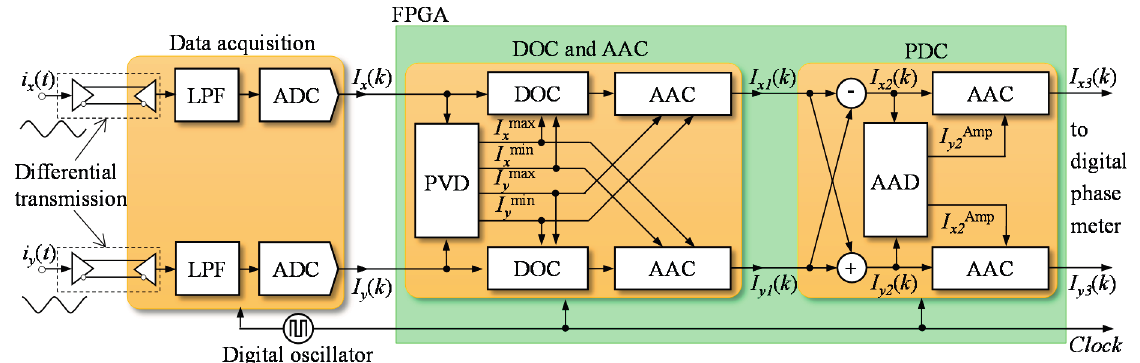
Figure 3. Block diagram of the approach for real-time compensation of cyclic error. A